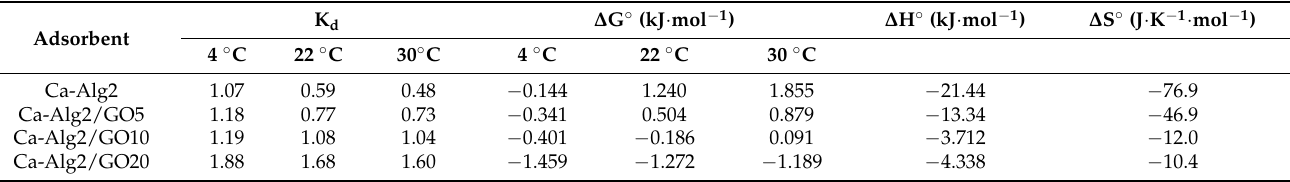
Table 1. Thermodynamic parameters for MB adsorption on Ca-Alg2, Ca-Alg2/GO5, Ca-Alg2/GO10 and Ca-Alg2/GO20 beads. Adsorbent